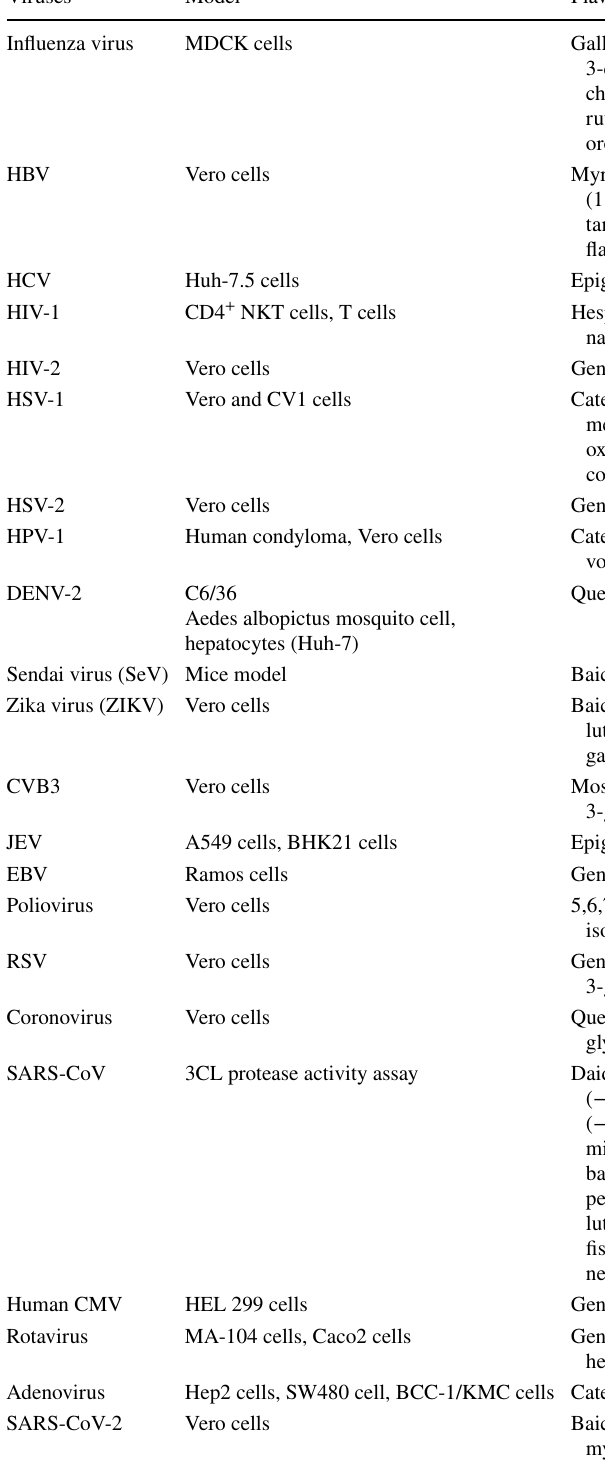
Table 1 The different viruses which inhibited by various flavonoids